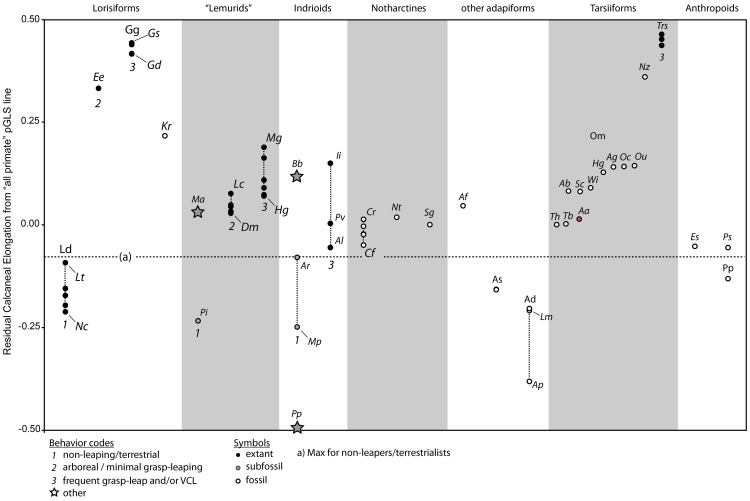
Box plots of residual elongation.We plot species mean values for residual elongation from the all primate line (Residual A from Table 1). The distribution of values within clades corresponds very well to degree of agility of locomotion. For fossils the variation corresponds with locomotor agility hypotheses based on additional skeletal features [30]. When these residual data sets are examined with phylogenetic ANOVA, a strong relationship between elongation and behavior is revealed (Table 7) meaning that calcaneal elongation is broadly related to behavior in contrast to the conclusion of Moyà-Solà et al. [7]. See previous figures for taxon abbreviations.